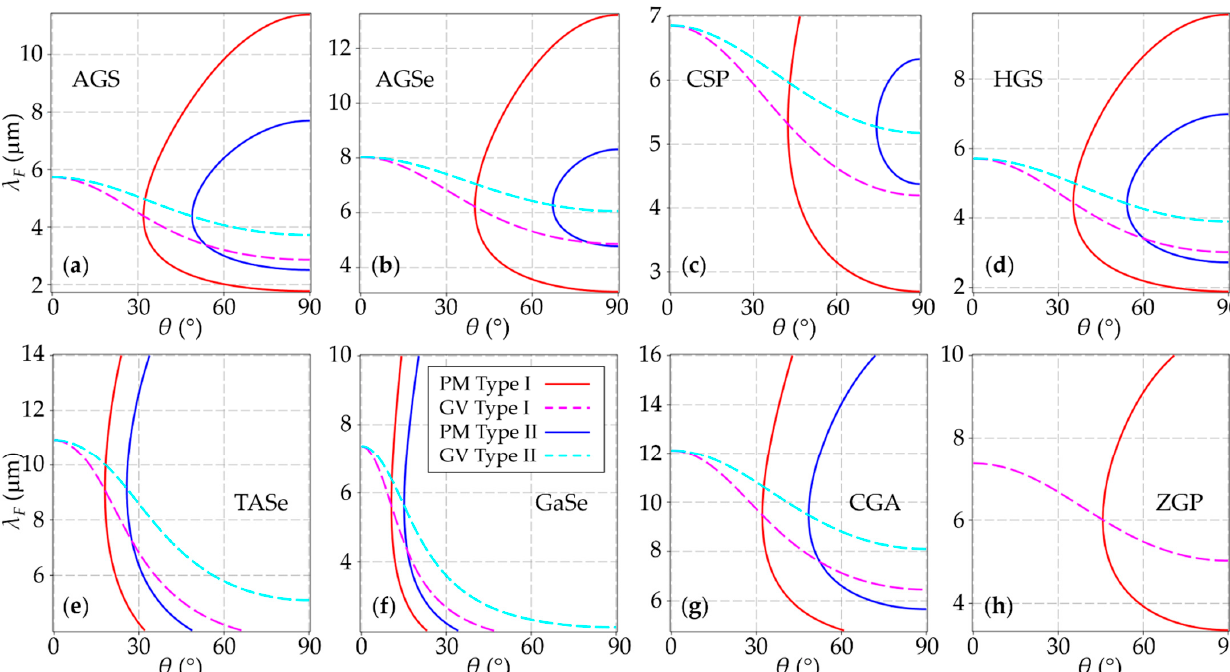
Figure 4. BPM and GV matching curves of ( a ) AGS, ( b ) AGSe, ( c ) CSP, ( d ) HGS, ( e ) TASe, ( f ) GaSe, ( g ) CGA, and ( h ) ZGP. The intersection of the red and magenta (or blue and cyan) curves indicates the direction of the F-wave vector (i.e., θ ) and the λ F value corresponding to the SH resonance for Type I (or Type II). Table 6. Broadband SHG conditions in mid-IR uniaxial crystals: the resonant F-wavelengths ( λ F ) and the corresponding SH wavelengths, ( λ SH ); the BPM direction ( θ BPM ); the effective NLO coefficients ( d eff ); the maximum walk-off angles between the interacting waves ( w ); and the acceptable F-bandwidths for the broadband SHG ( ∆ λ F ). Crystals